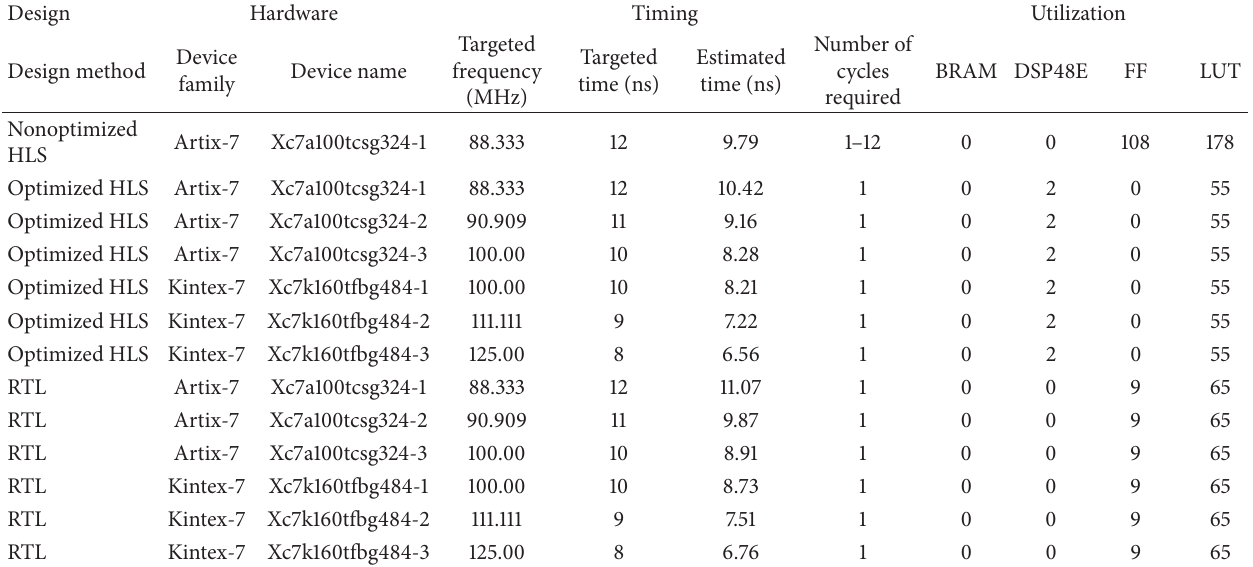
Table 3: Device utilization and maximum operating speed of (SOM) defuzzification module.